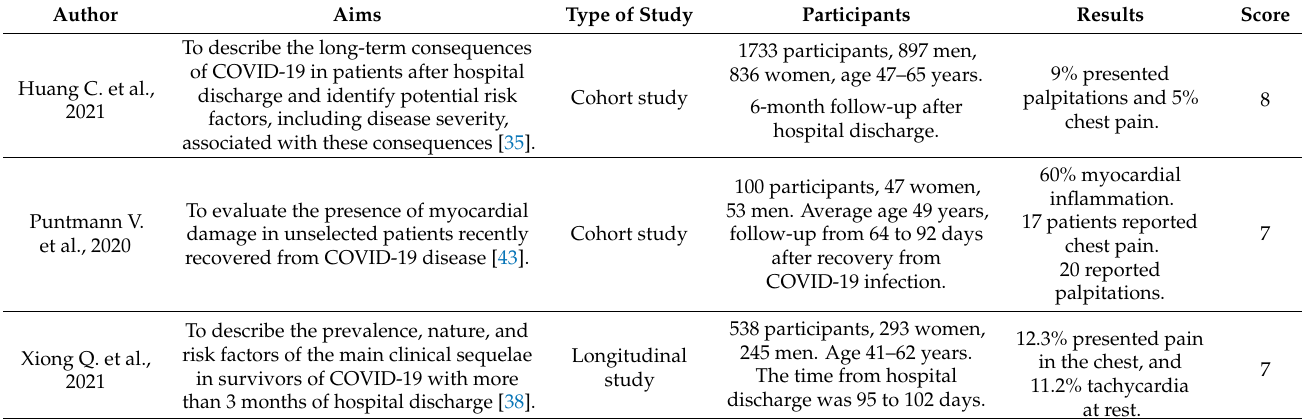
Table 2. Summary of literature mentioning cardiac